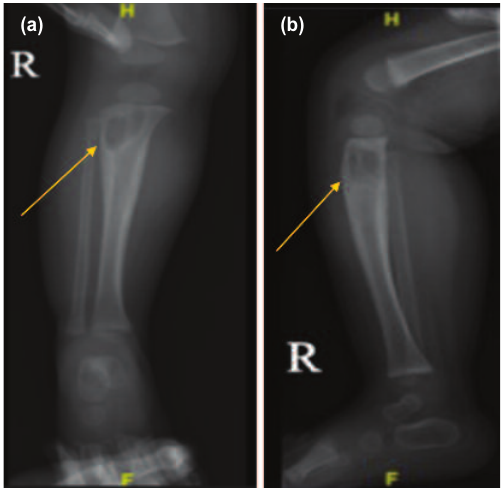
Well-defined radiolucent bone lesions at metaphysis Fig. 1: with reactive periosteum thickening seen on (a) right tibia AP view, (b) right tibia lateral view.